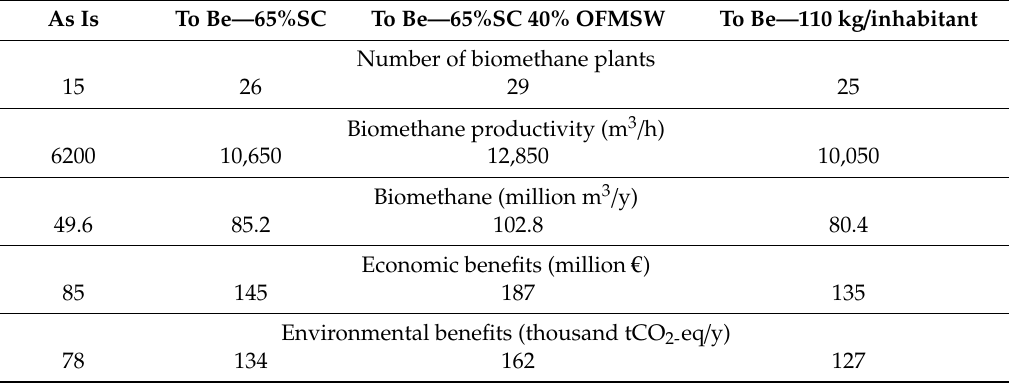
Table 10. Main results in the 15 municipalities from managing the OFMSW—baseline scenario.